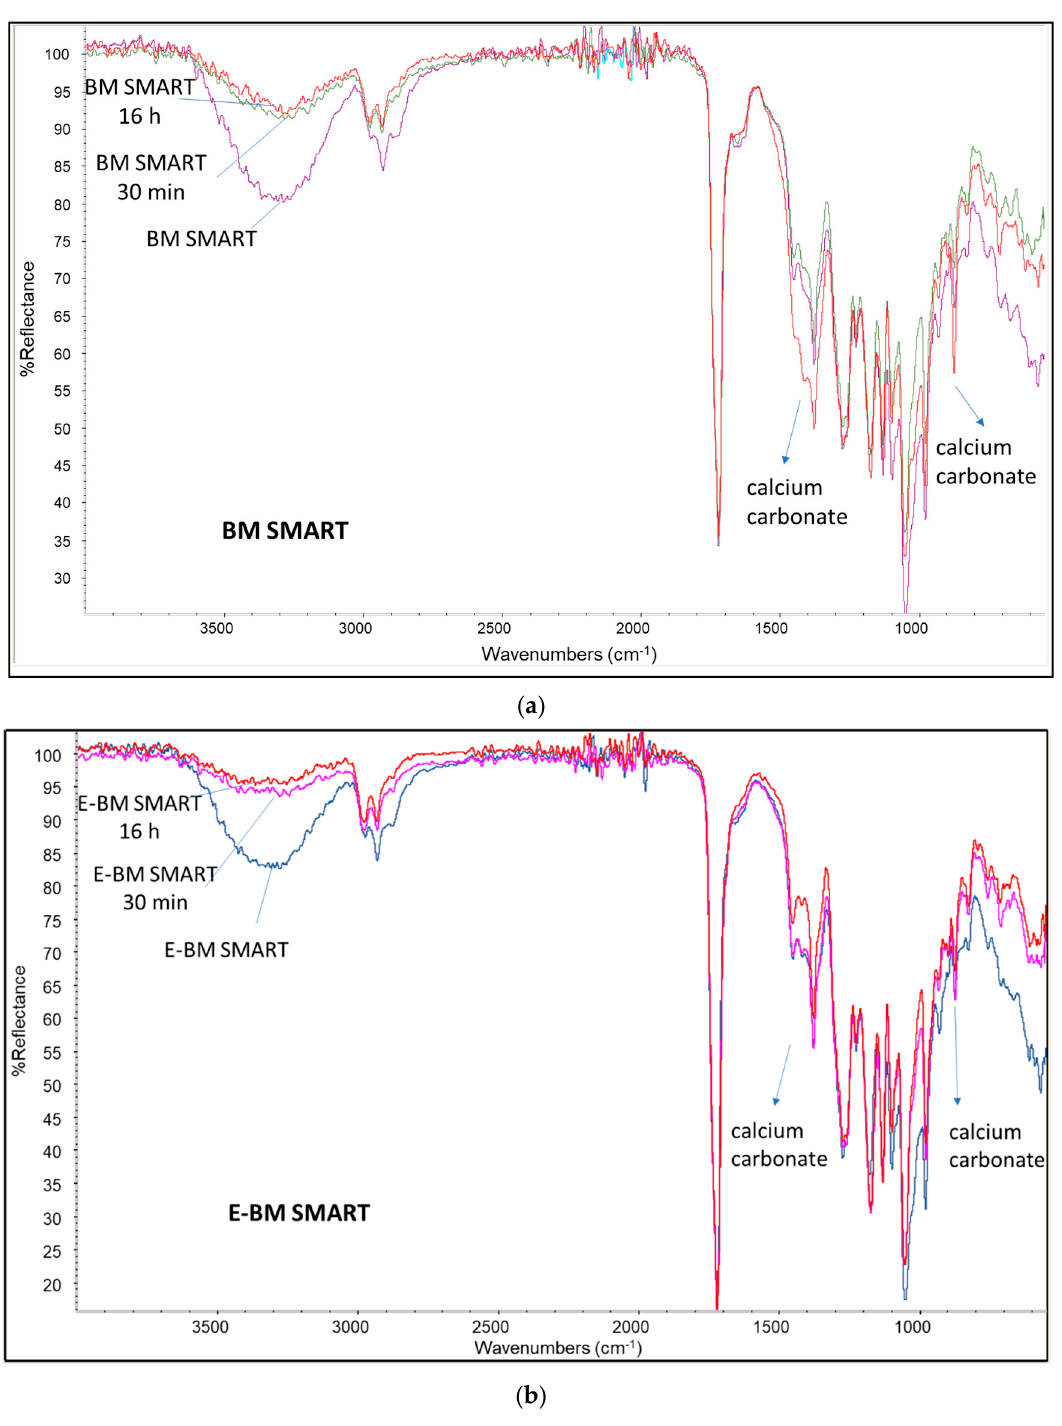
Figure 4. Infrared spectra of films before and after immersion in water at different times (30 min and 16 h): ( a ) spectrum of BM SMART (purple) and the same after water extraction of 30 min (green) and 16 h (red); ( b ) spectrum of E-BM SMART (blue) before and after water extraction of 30 min (pink) and 16 h (red).